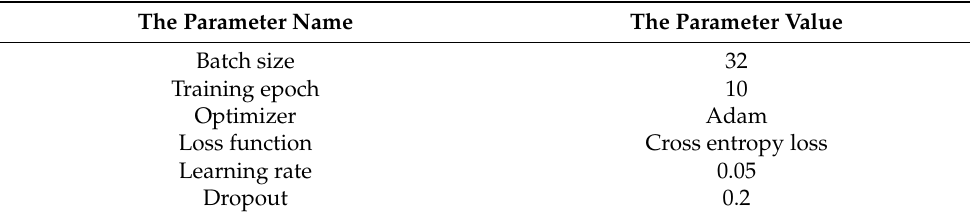
Table 3. Multiclassifier training parameters.